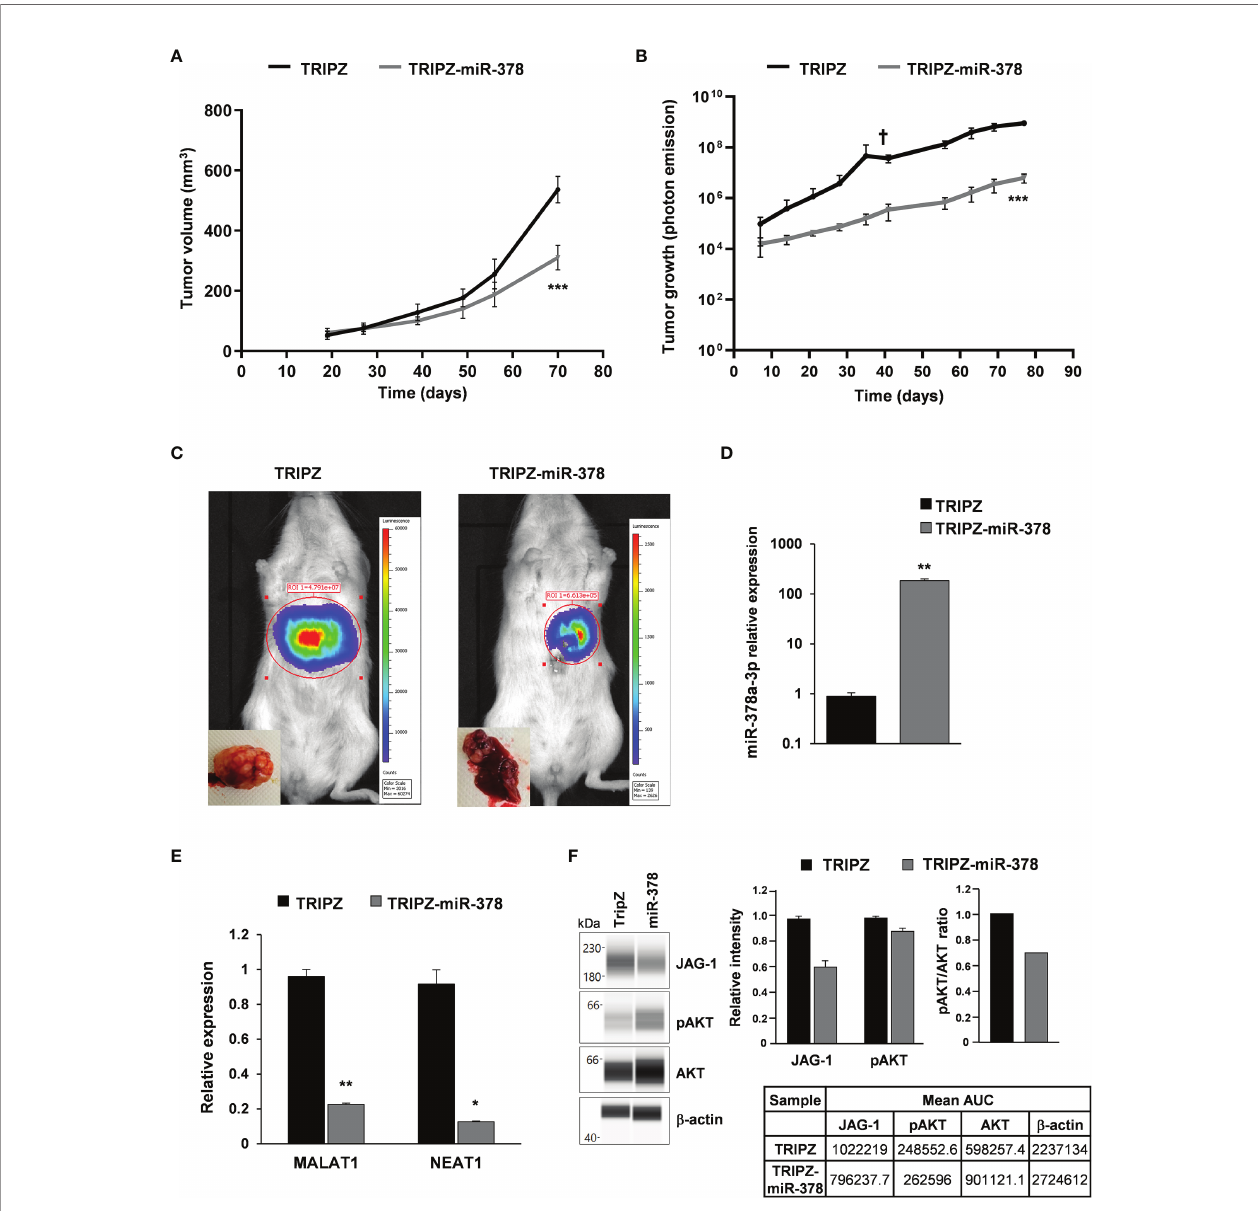
FIGURE 5 | miR-378a-3p restoration reduces tumor growth of patient-derived CRC-SC xenografts. (A) Tumor growth curves of subcutaneous xenografts generated by the injection of CRC-SC#18 LUC-GFP TRIPZ (n=4) or LUC-GFP TRIPZ-miR-378 (n=4). Values represent volume (mm 3 ) of xenograft tumors at different time points after injection. Values are reported as mean ± SD. Statistical comparison is reported for the latest time point and was calculated by means of Student ’ s t-test. ***p<0.001. (B) Tumor growth curves of liver xenografts generated by the injection of CRC-SC#18 LUC-GFP TRIPZ (n=5) or LUC-GFP TRIPZ-miR-378 (n=5). Values represent luciferase photon emission of xenograft tumors at different time points after injection. Values are reported as mean ± SD. Statistical comparison is reported for the latest time point and was calculated by means of Student ’ s t-test. ***p<0.001. † indicates the death of one mouse xenografted with CRC-SC#18 LUC-GFP TRIPZ 41 days after injection. (C) Representative images showing the bioluminescent signal of the CRC-SC#18 LUC-GFP TRIPZ ( left ) and CRC-SC#18 LUC-GFP TRIPZ-miR-378 ( right ) liver tumor xenografts acquired by IVIS imaging system at 41 days after injection. Representative images of the liver excised at the end of the experiment ( bottom left ). (D) MiR-378a-3p expression was analyzed by qRT-PCR in CRC-SC#18 LUC-GFP TRIPZ or LUC-GFP TRIPZ-miR-378 retrieved by fl uorescent-activated cell sorting from liver tumor xenografts. (E) MALAT1 and NEAT1 expression was analyzed by qRT-PCR in CRC-SC#18 LUC-GFP TRIPZ or LUC-GFP TRIPZ-miR-378 retrieved by fl uorescent-activated cell sorting from liver tumor xenografts. *p<0.05, **p<0.01, based on Student ’ s t test. (F) Wes full-length gel image of JAG-1, pAKT and AKT expression in CRC-SC#18 LUC-GFP TRIPZ or LUC-GFP TRIPZ-miR-378 retrieved by fl uorescent-activated cell sorting from liver tumor xenografts ( left panel ). The relative amount of each immunoreactive band and the pAKT/AKT ratio was shown ( right panel ). The protein expression was quanti fi ed using AUC (area under the curve) measurements generated using Compass Software. Signal intensity was normalized to the b -actin level in the same